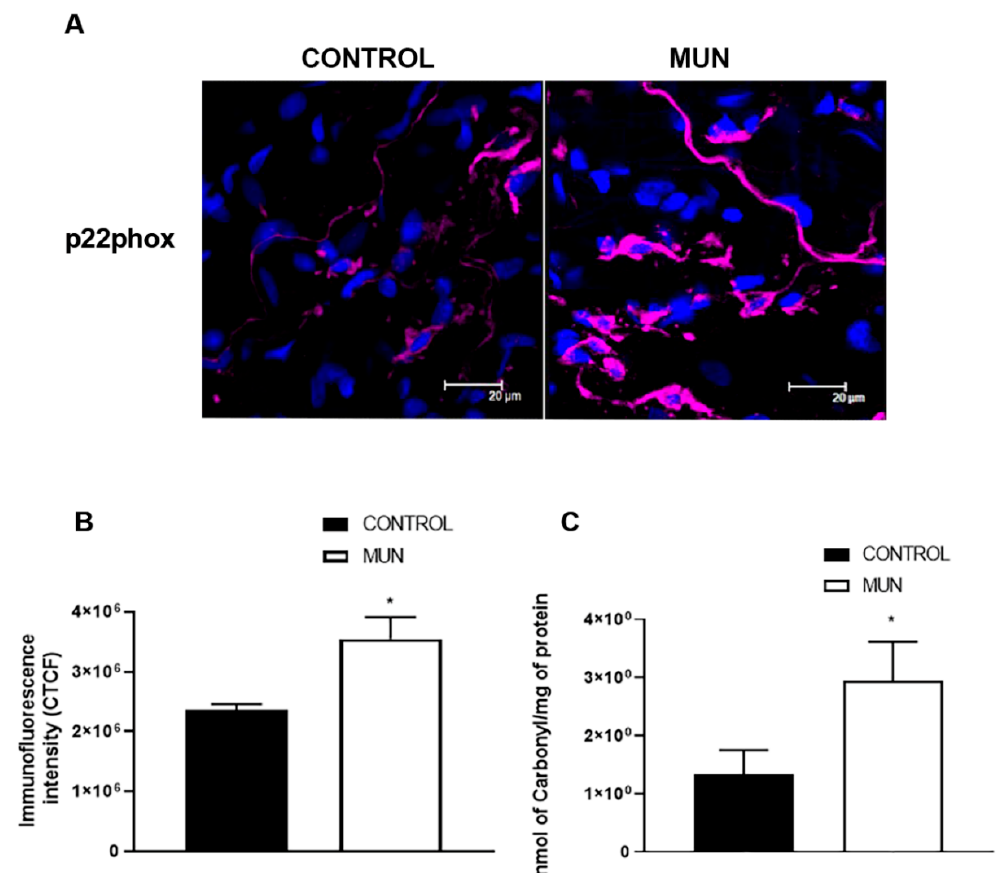
Figure 4. Influence of fetal undernutrition on NADPH oxidase and oxidative stress in 6-month-old male offspring from rats exposed to maternal undernutrition during pregnancy (MUN) and rats fed ad libitum (CONTROL). ( A ) Laser scanning confocal microscopy representative images of CONTROL and MUN mesenteric arteries exhibiting p22phox (red) and the nuclei (blue); ( B ) quantitative analysis of LSCM images. ( C ) Plasma oxidative status (levels of Carbonyls). Values are mean ± s.e.m. from 6 rats in each group. Significant differences from CONTROL rats: * p < 0.05.